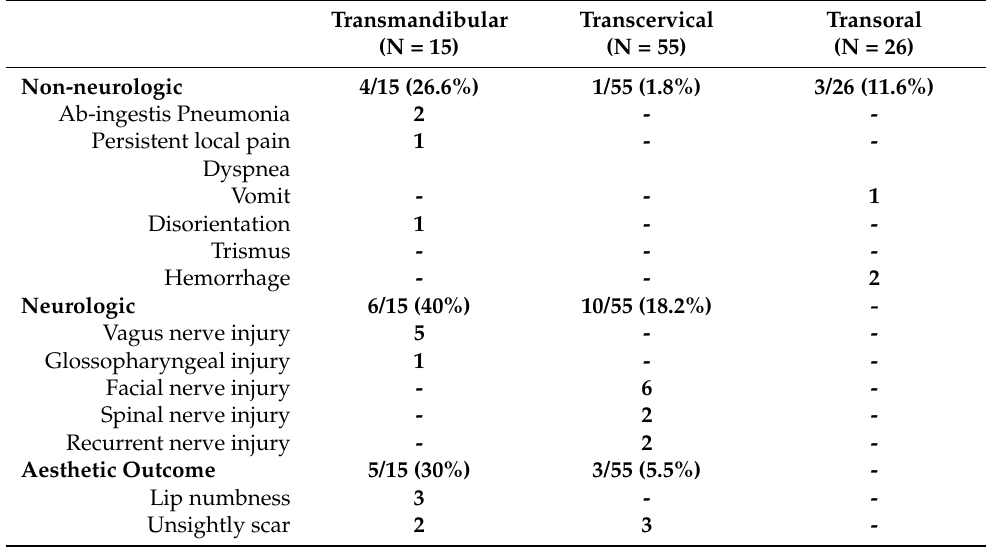
Table 2. Post-operative